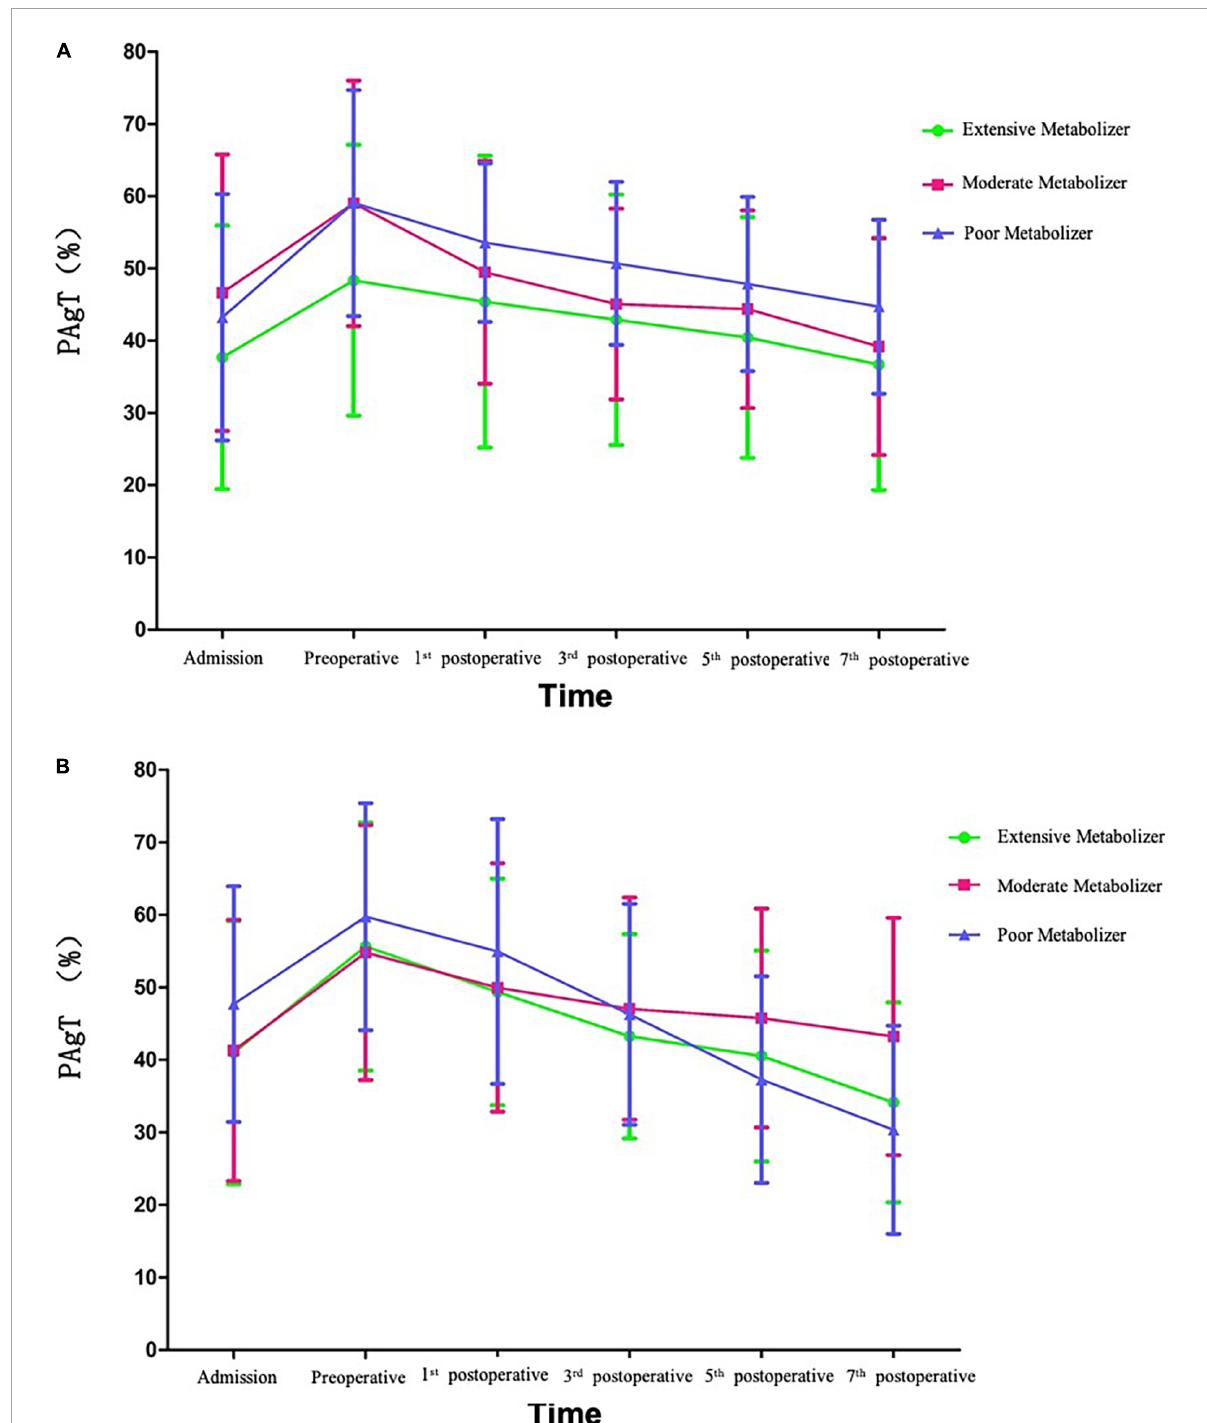
FIGURE2 Tendency of platelet aggregation rate in traditional dual antiplatelet therapy (DAPT) group (A) and individual DAPT group (B) .